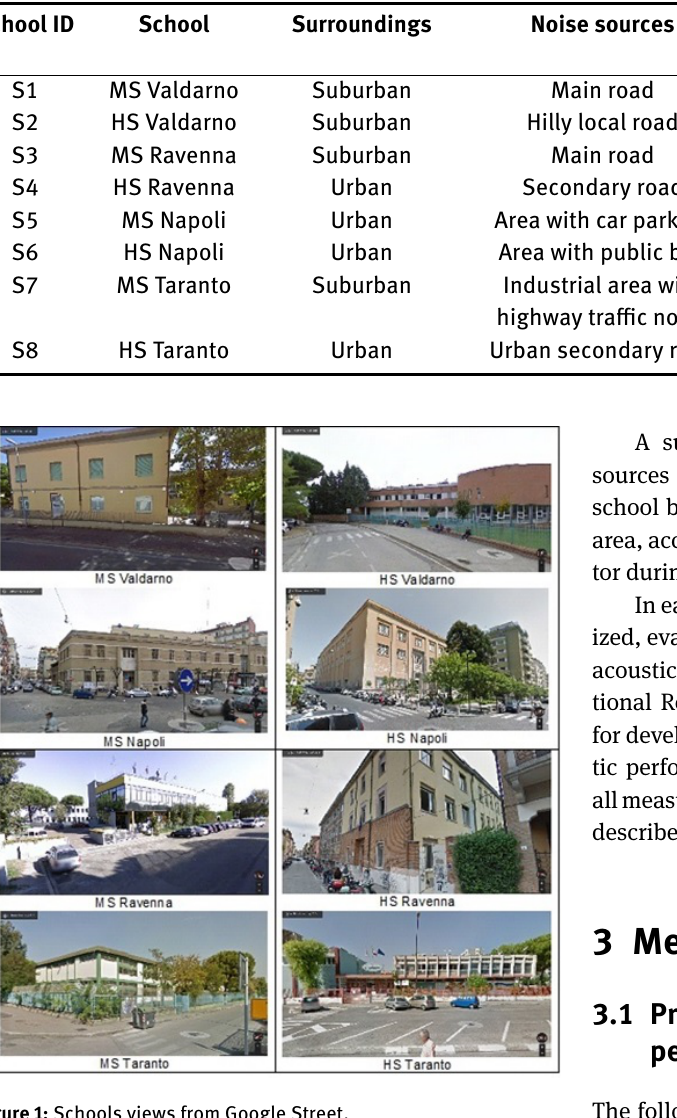
Figure 1: Schools views from Google